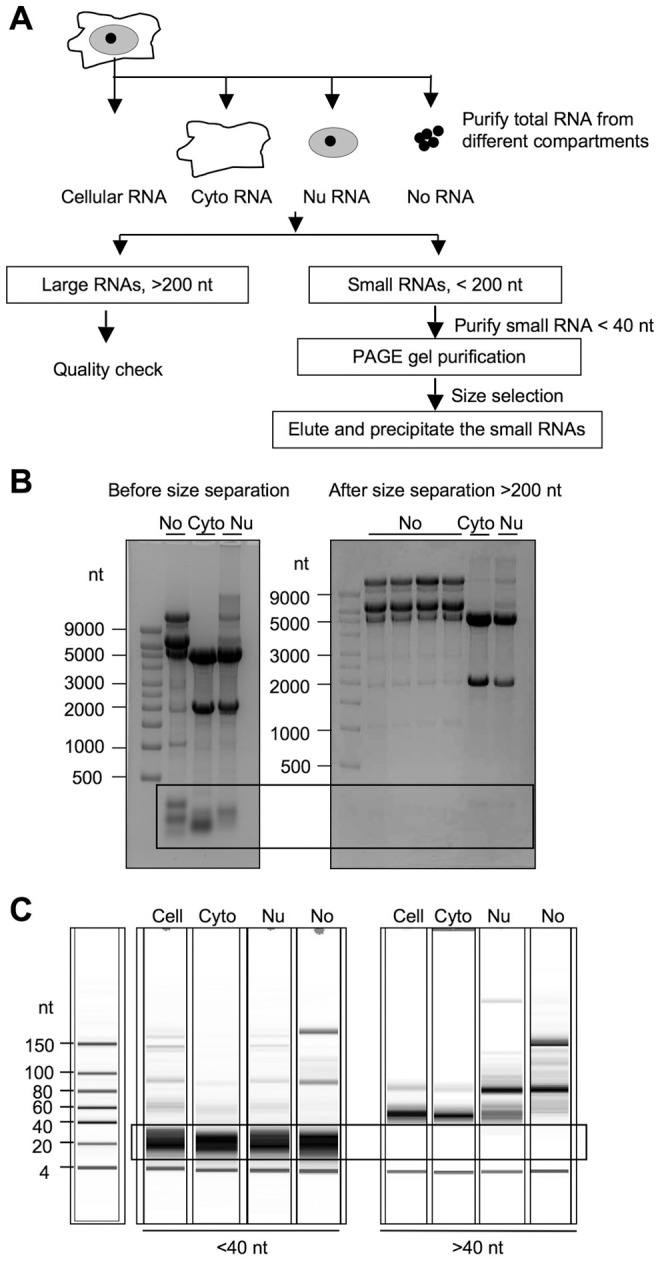
sRNA-seq strategy and preparation of small RNA libraries.
A Subcellular fractionation and RNA purification scheme. Cyto, cytoplasmic; Nu, nuclear; No, nucleolar. B RNA-PAGE analysis by 16% denaturing PAGE before (left) and after (right) purification of the <200 nt RNA fraction. Subcellular fractions are indicated at the top. C RNA profiles of the <40 nt (left) and >40 nt fractions (right) as analyzed by BioAnalyzer. Subcellular RNA fractions are indicated on top, RNA size markers to the left.